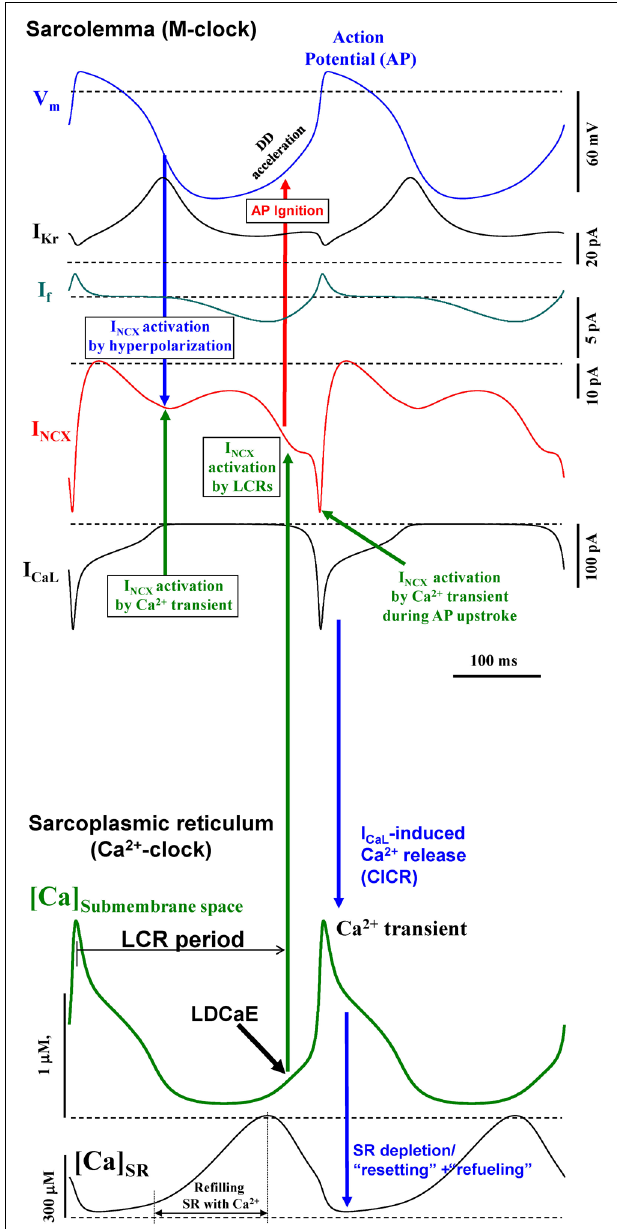
FIGURE 2 | Coupled-clock Maltsev–Lakatta numerical model (Maltsev and Lakatta, 2009) predicts complex synergistic interactions between cell membrane and Ca 2 + cycling proteins within SANC (see “Integration of Ca 2 + and CaMKII Signaling within the Coupled-Clock System”). Modified from Maltsev and Lakatta